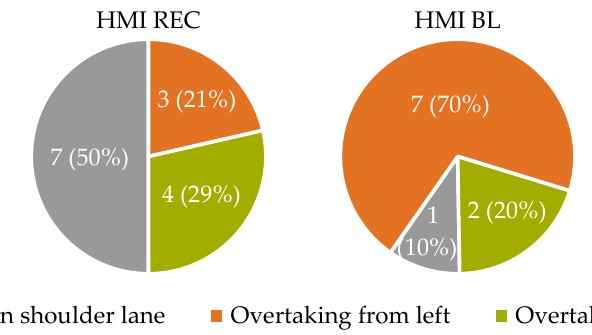
Figure 5. Manner of interventions during the scenario occupied